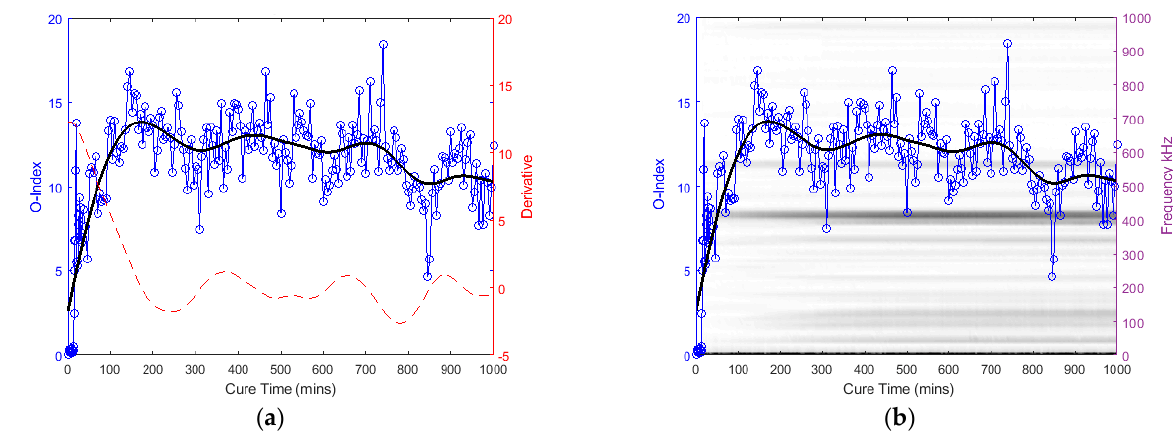
Figure 16. Triangular specimen (Near): O-Index with ( a ) its time derivative and ( b ) its change in